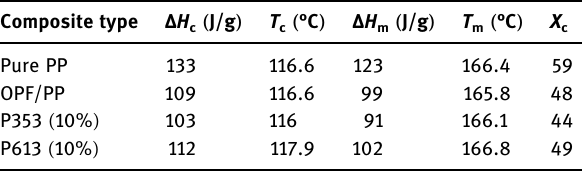
Table 3: Thermal parameters of the OFP/PP composites extracted from DSC